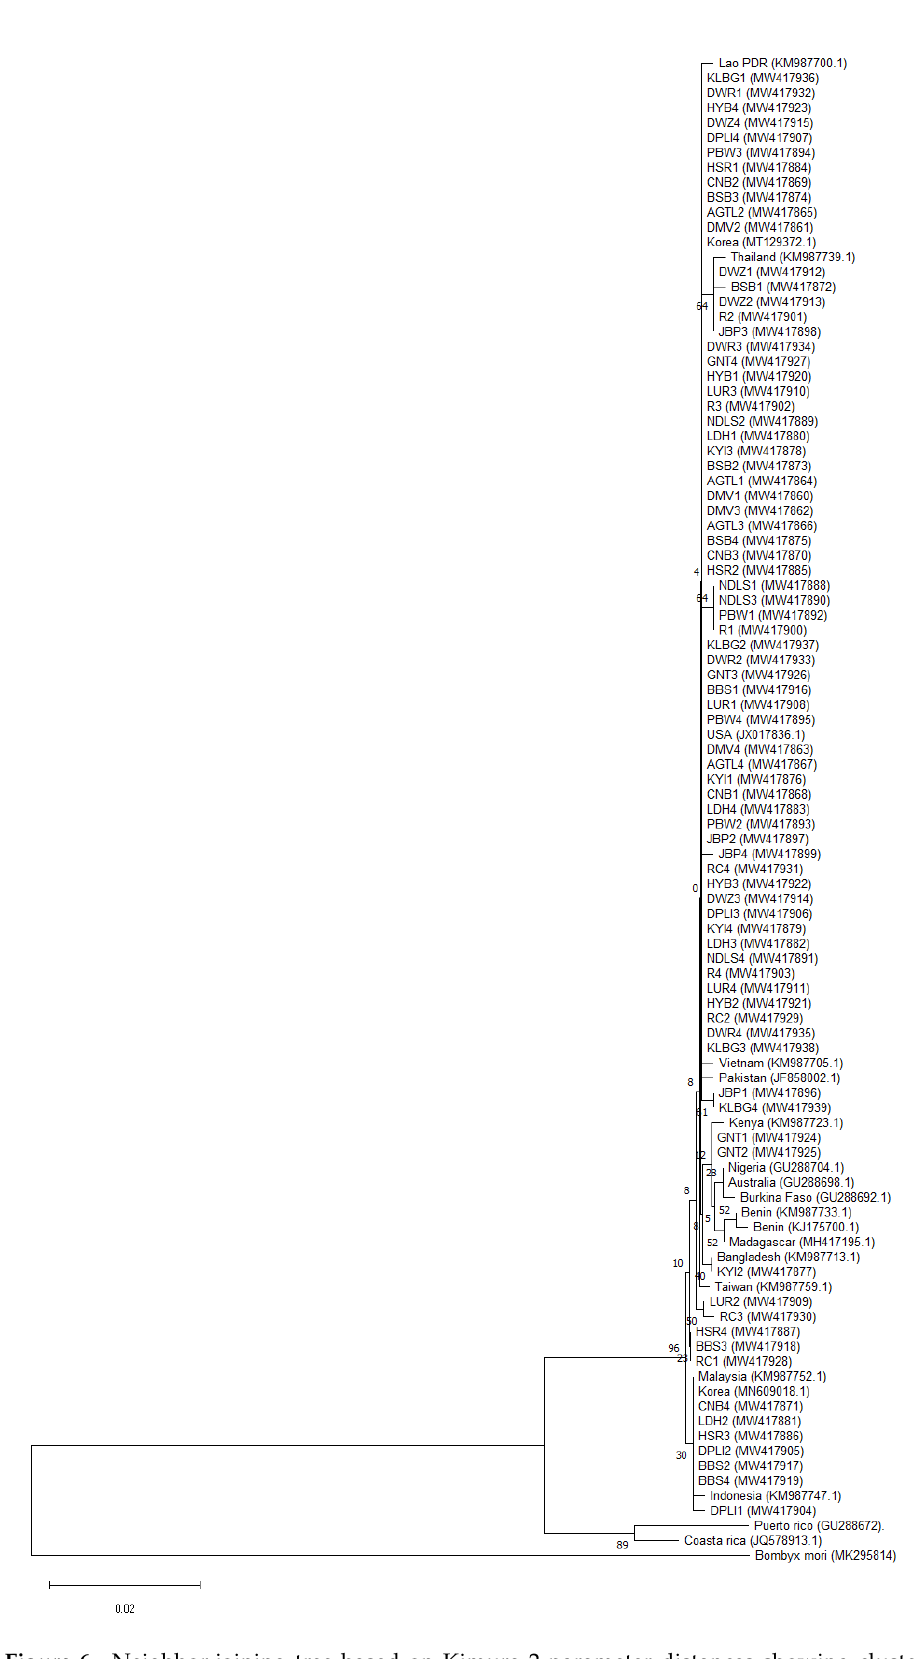
Figure 6. Neighbor-joining tree based on Kimura 2-parameter distances showing clustering of M. vitrata populations for COI gene. Numbers at branch point indicate 10,000 bootstrap values. Bombyx mori (accession #MK295814) was used as outlier sequence.